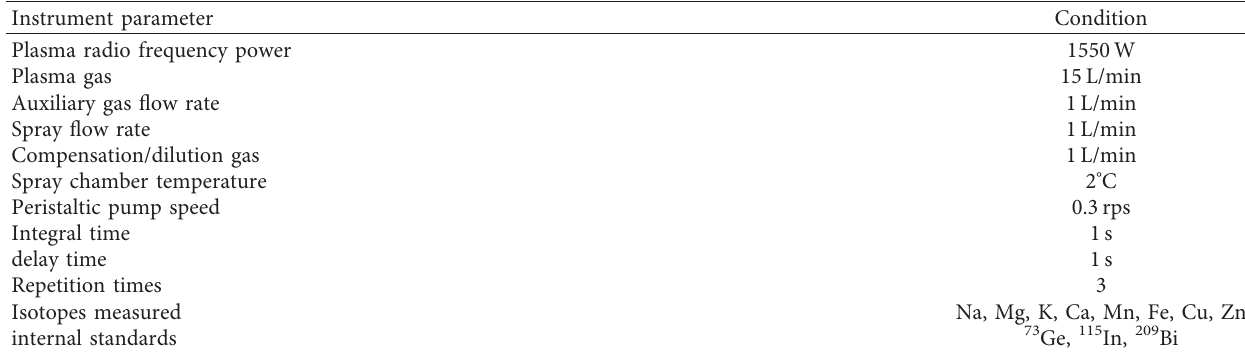
Figure 1: MRM chromatogram of 13 compounds investigated in the mix standards (a) and sample (b) of DG. (1) Chlorogenic acid, (2) caffeic acid, (3) vanillin, (4) ferulic acid, (5) senkyunolide I, (6) senkyunolide H, (7) coniferyl ferulate, (8) senkyunolide A, (9) butylphthalide, (10) butylidenephthalide, (11) Z-ligustilide, (12) neocnidilide, and (13) levistilide A. Table 3: Optimum ICP-MS operating conditions for the analysis of